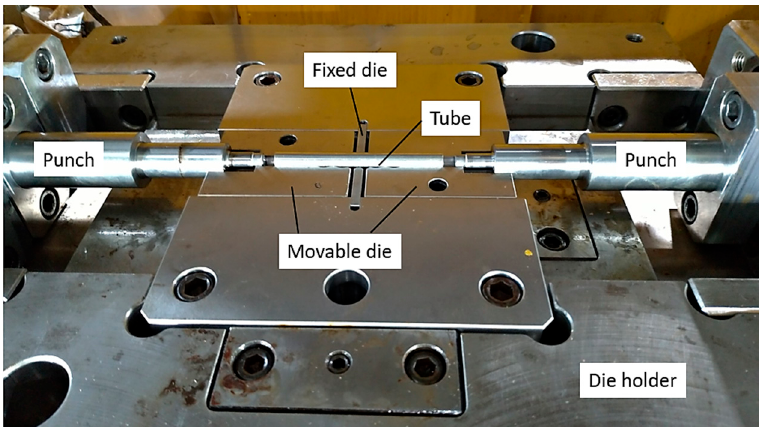
Figure 13. Completed lower part of movable die set for hydroforming experiments.